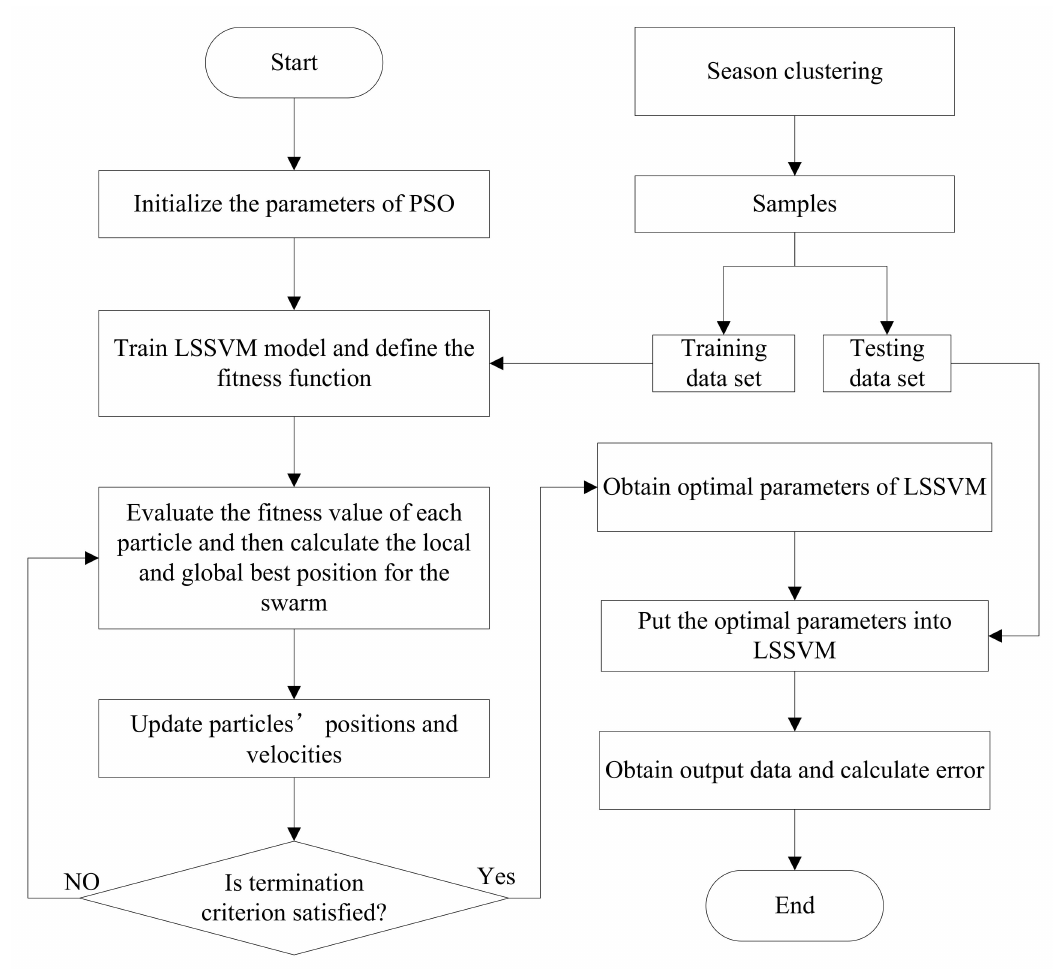
Figure 1. Flow chart of the procedure of the particle swarm optimization-least squares support vector machine